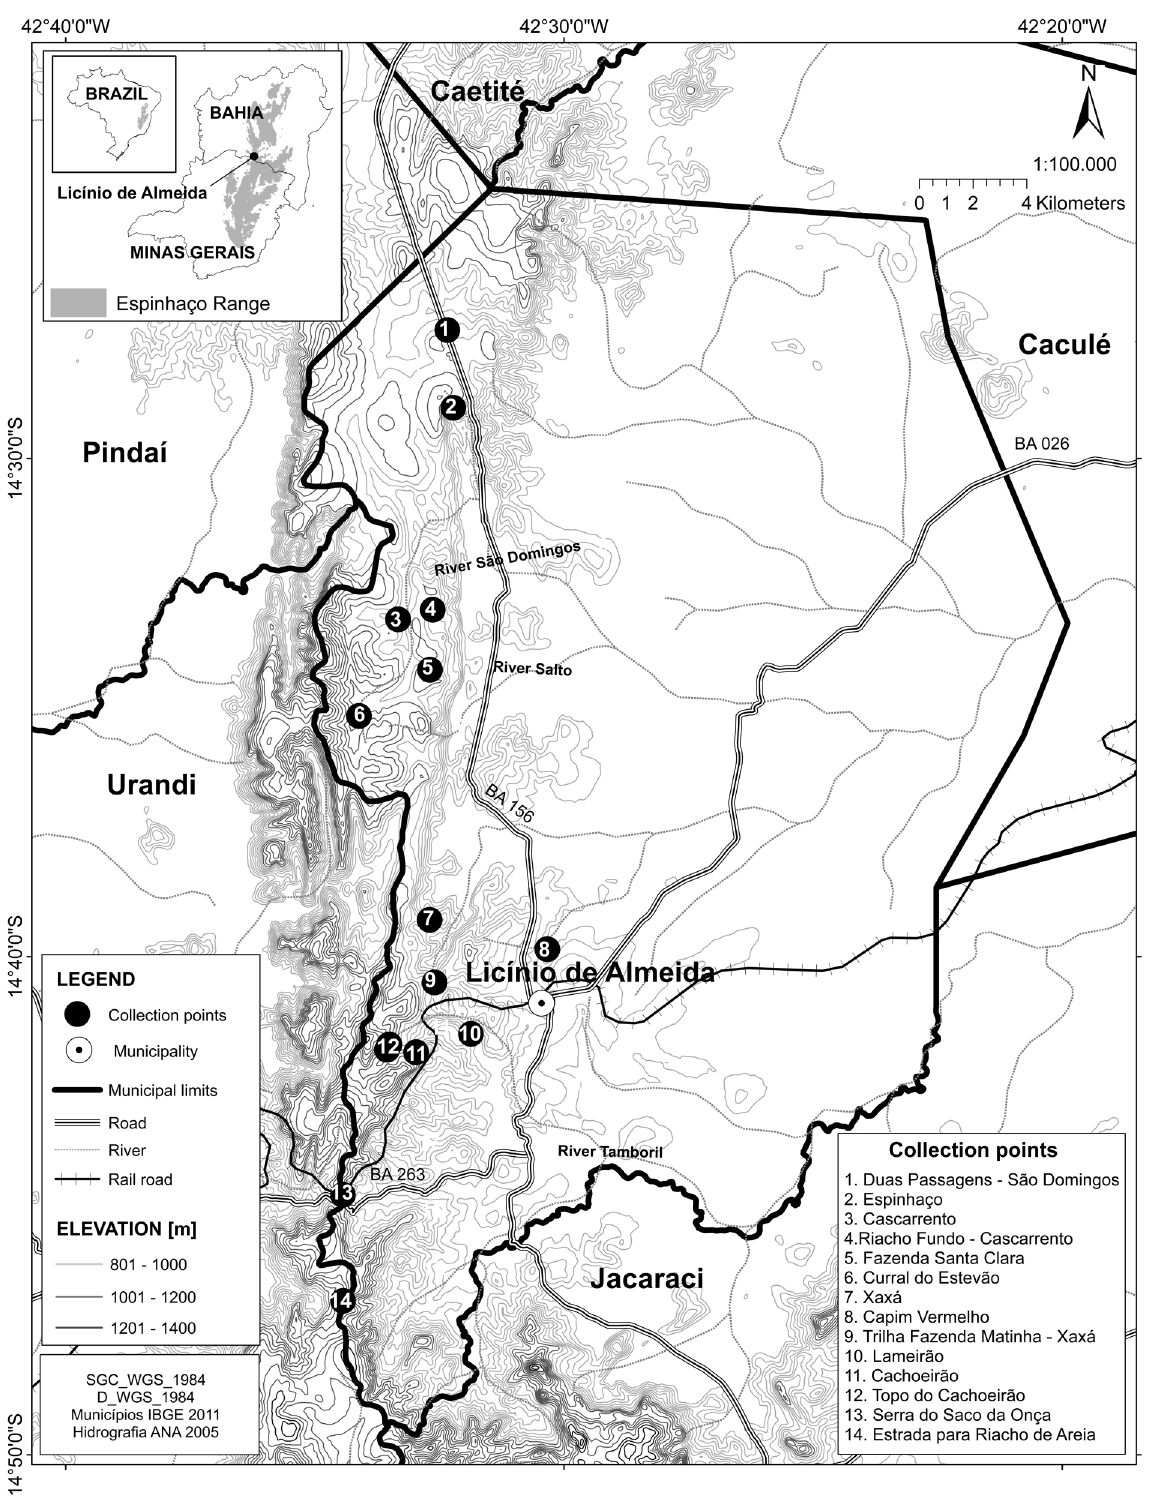
Figure 1. Serra Geral and collecting points of the species in the Licínio de Almeida municipality, Bahia,